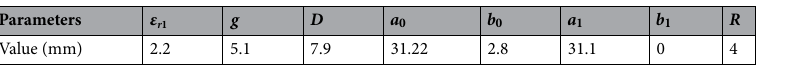
Table 2. Design parameters of the mantle cloaked patch antenna.